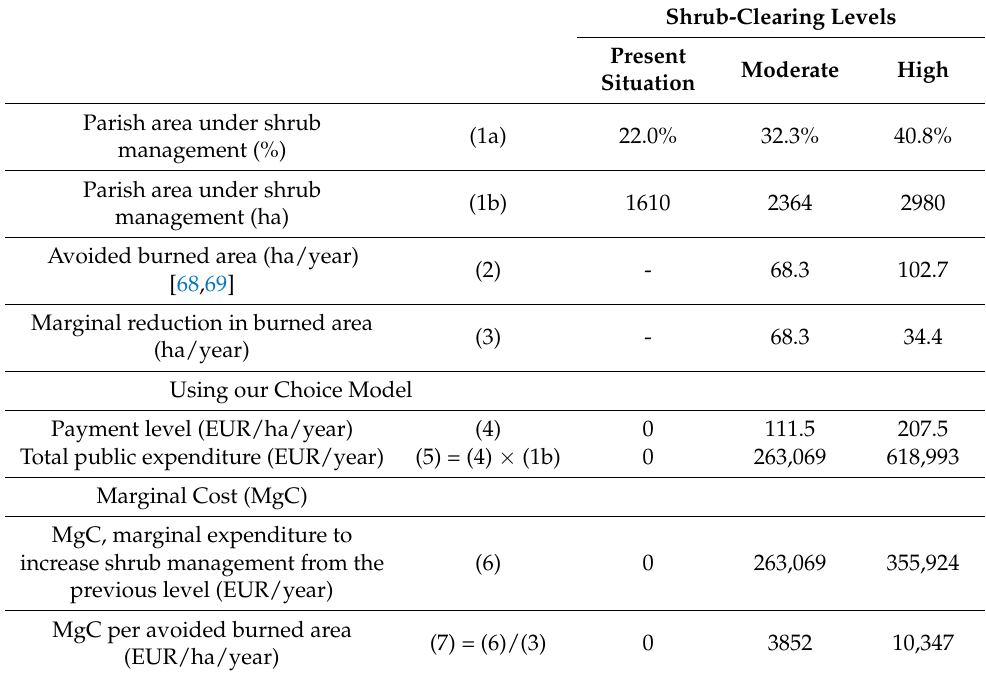
Table 5. Marginal cost calculation using combined fire and choice models for shrub clearing every five